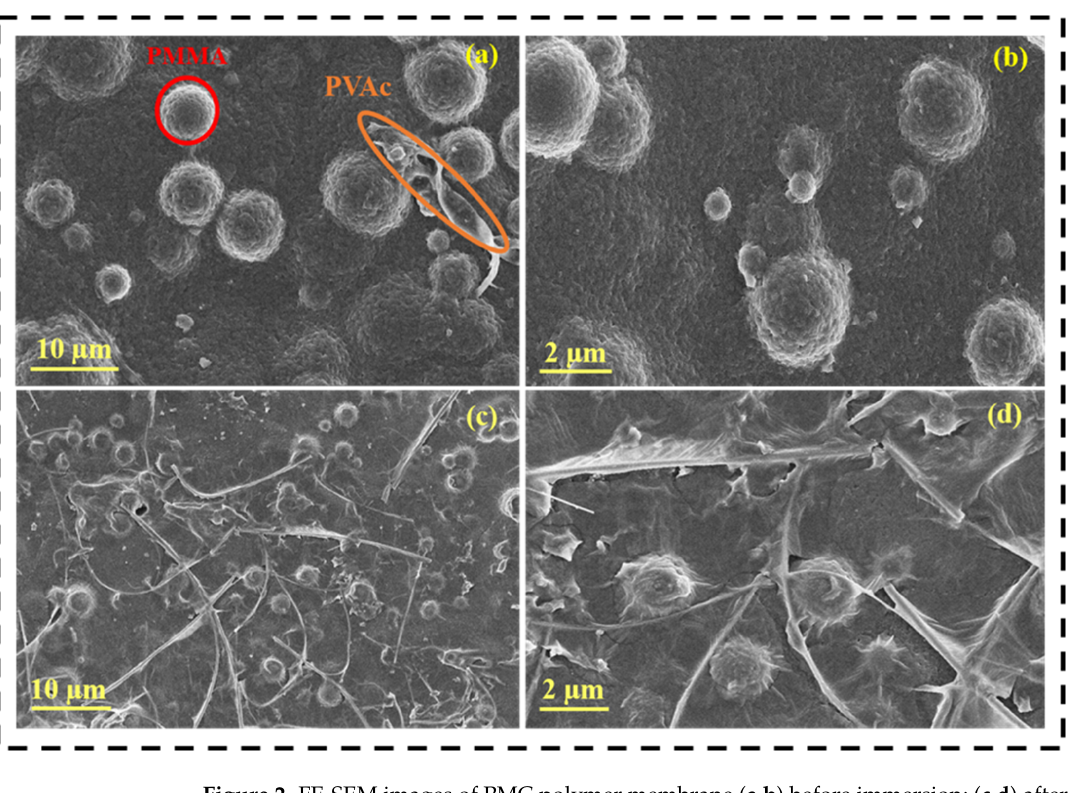
Figure 2. FE-SEM images of PMC polymer membrane ( a , b ) before immersion; ( c , d ) after immersion.